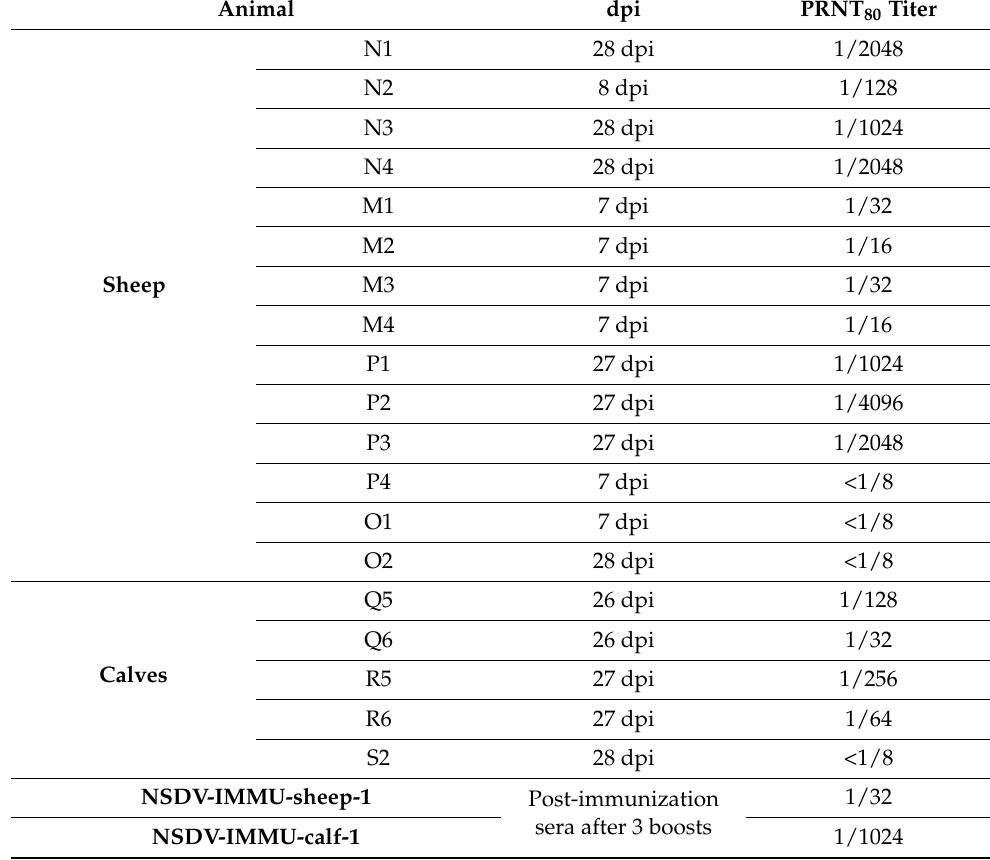
Table 5. PRNT 80